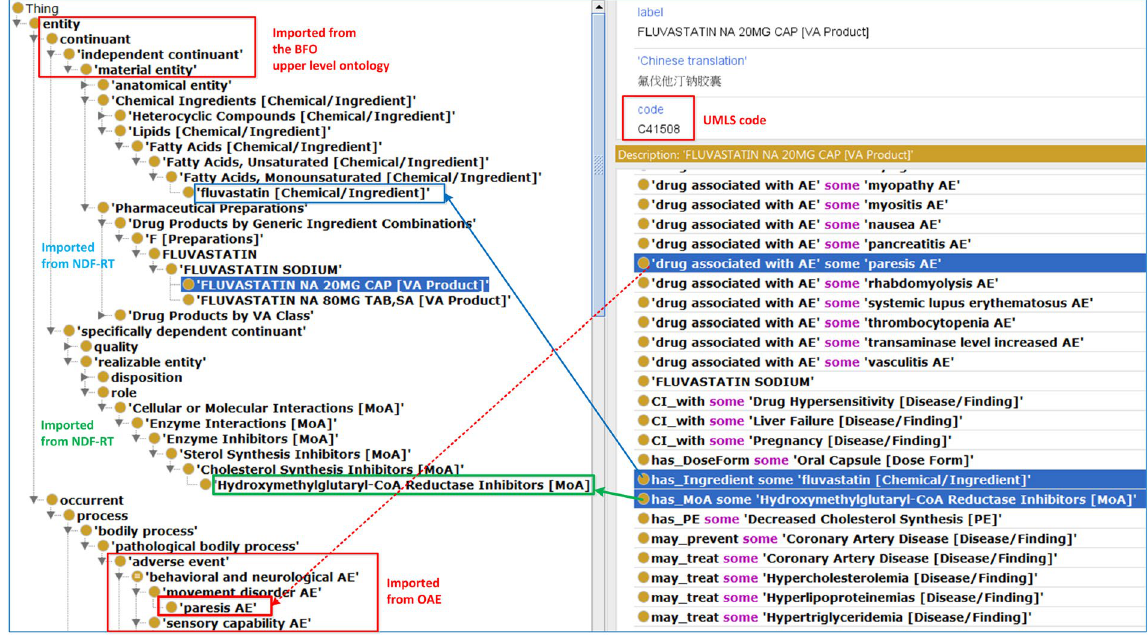
Figure 3. Integrative OCVDAE ontology representation of drugs, AEs, drug ingredients, and MoAs. This is a screenshot of Protégé OWL editor of a subset of OCVDAE after OntoFox extraction of two Fluvastatin drugs and their associated terms from OCVDAE. As shown in this figure, OCVDAE imports many terms from NDF-RT and OAE and uses the BFO as the upper level ontology. Each drug (e.g., Fluvastatin NA 20 MG CAP) is associated with its ingredient, MoA, and specific AE terms (e.g., paresis AE). These terms and their parent upper level terms are organized in a well-defined hierarchy in